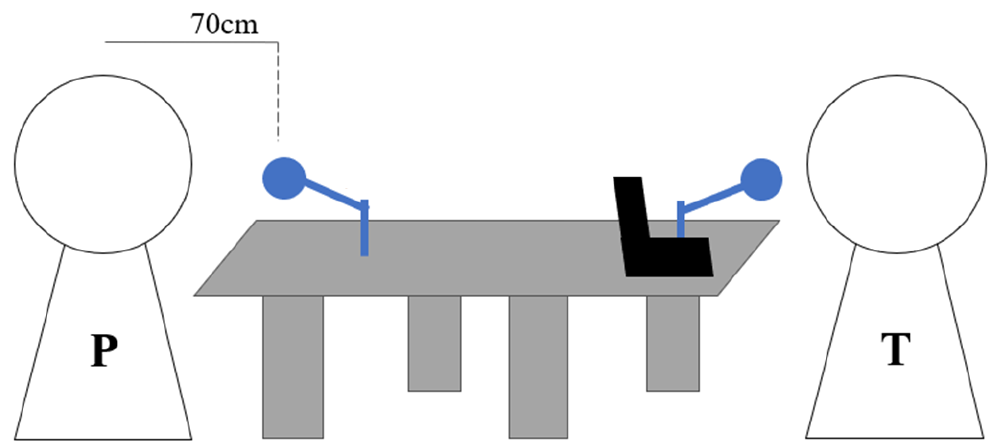
Figure 1. Recording setup during interview session. P is the patient and T is the psychiatrist. There is a distance of approximately 70 cm between the patient’s seat and the recording